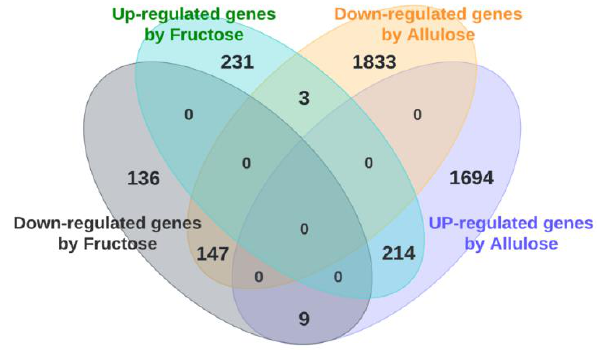
Figure 1. Clustering analysis.